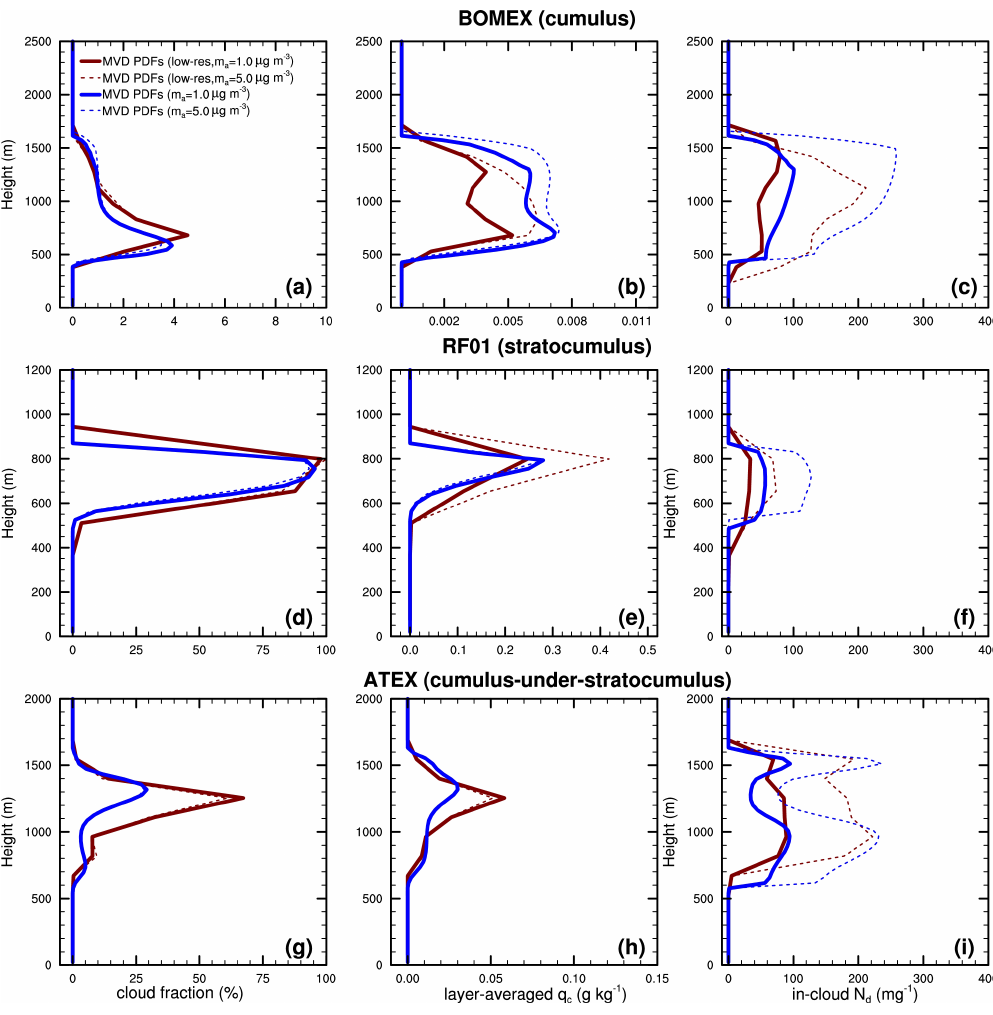
Fig. A2. Similar to Fig. 2 but at different